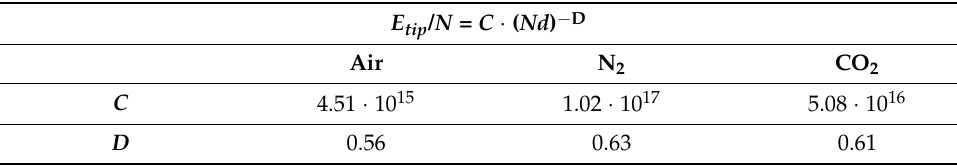
Table 2. Parameters C and D for fitting function (6) for air, N 2 and CO 2.